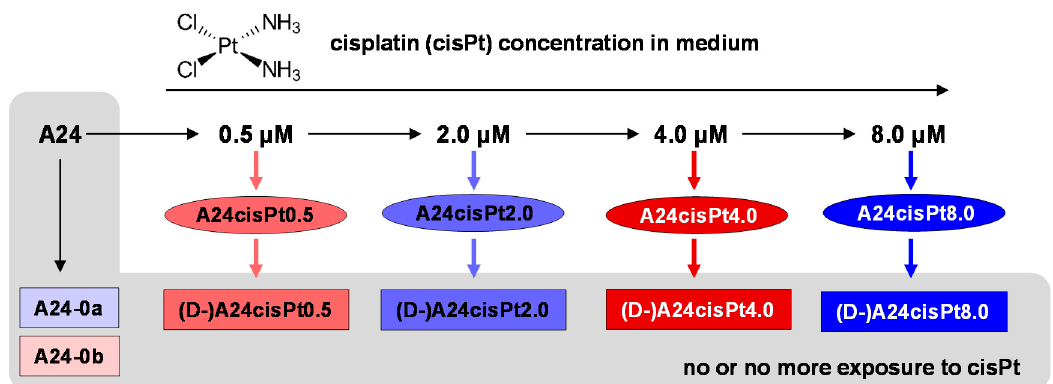
Figure 1. Overview of examined lung adenocarcinoma (A24) cell cultures prepared in two batches (red and blue) either not exposed to cisPt, exposed to increasing cisPt concentrations (ellipsoids) and de-induced (no more cisPt exposure for more than 3 months, rectangles). The color- and form-coding is maintained for all figures.